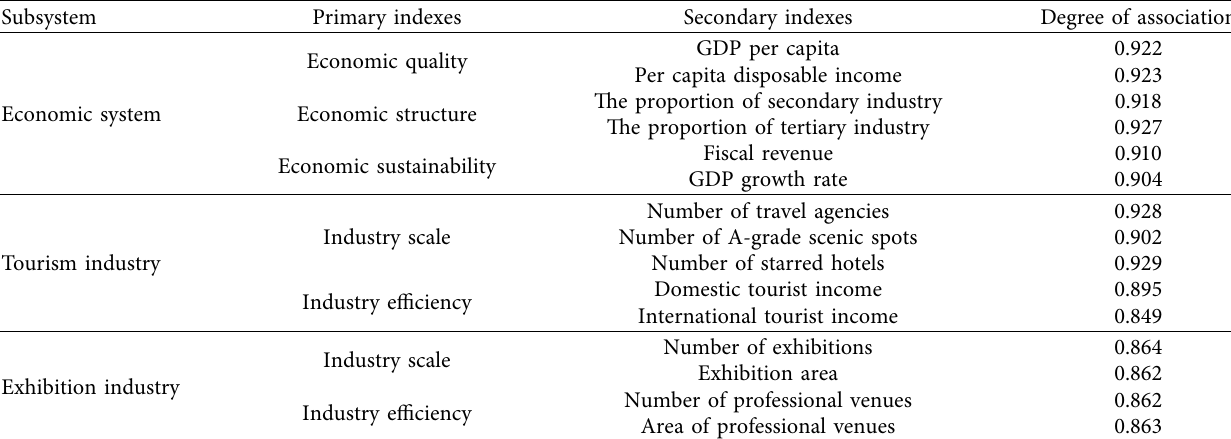
Table 4: Results of gray correlation analysis of measurement of secondary